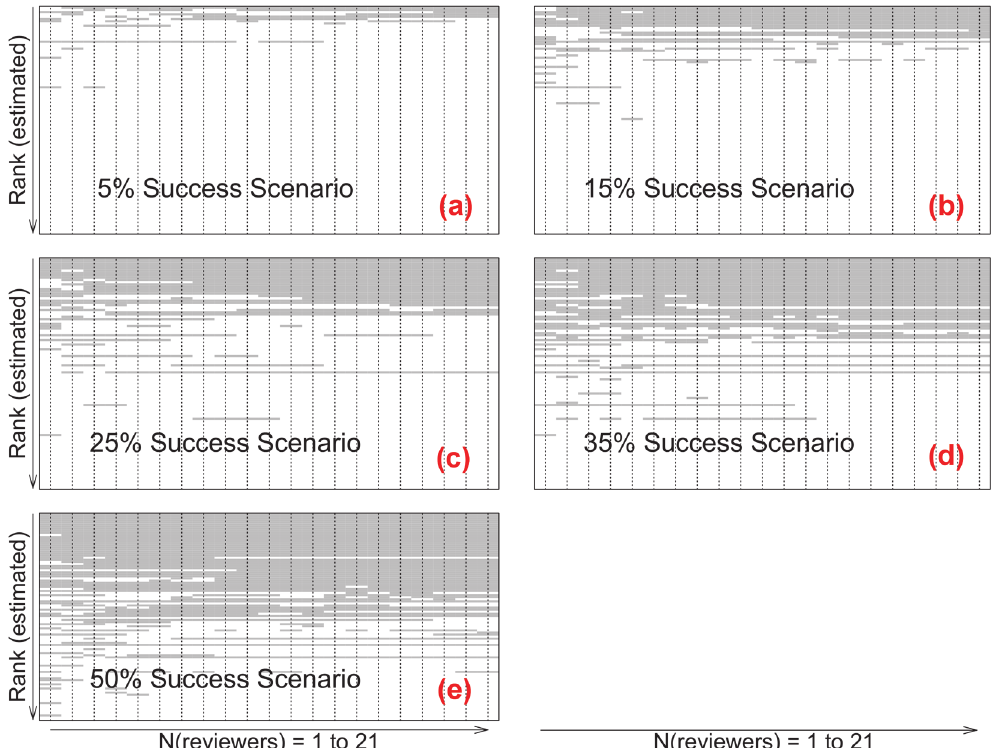
Fig 1. Simulated competition outcomes from a single bootstrap iteration (1 to 21 reviewers per application). Horizontal sequences represent simulated outcomes for each of 100 Fellowships applications ( ‘ grey ’ representing success) with incremental addition of reviewers, within different overall success rate scenarios. For each N to N+1 reviewers , an additional score was sampled (with replacement) from 9 independent assessments. Discontinuities in horizontal grey/white — coding reflect changes in decision outcome with addition of a single reviewer. Within each iteration (representing one simulated competition), the outcome for many applications was invariant where N > 2, regardless of the success rate